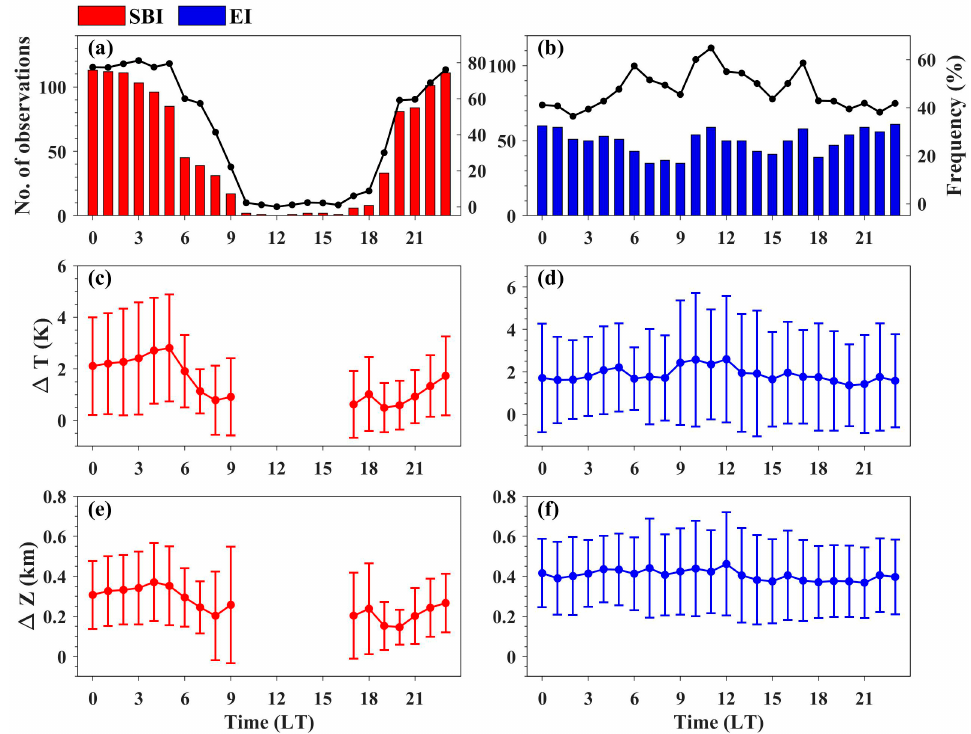
Figure 3. The diurnal variation of ( a ) observation number, ( c ) inversion intensity, and ( e ) inversion depth for SBI. The diurnal variation of ( b ) observation number, ( d ) inversion intensity, and ( f ) inversion depth for elevated temperature inversion. The black line represents the frequency of occurrence.